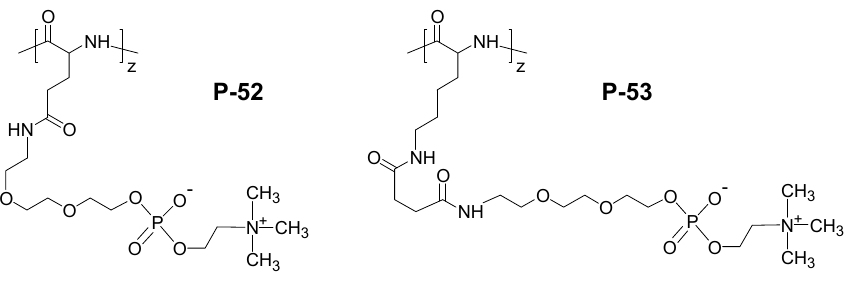
Figure 11. Polyzwitterions made by post-polymerization coupling of zwitterionic reagents onto a precursor polymer, exemplified for the fixation of phosphobetaine reagents onto poly(glutamic acid) and poly(lysine)